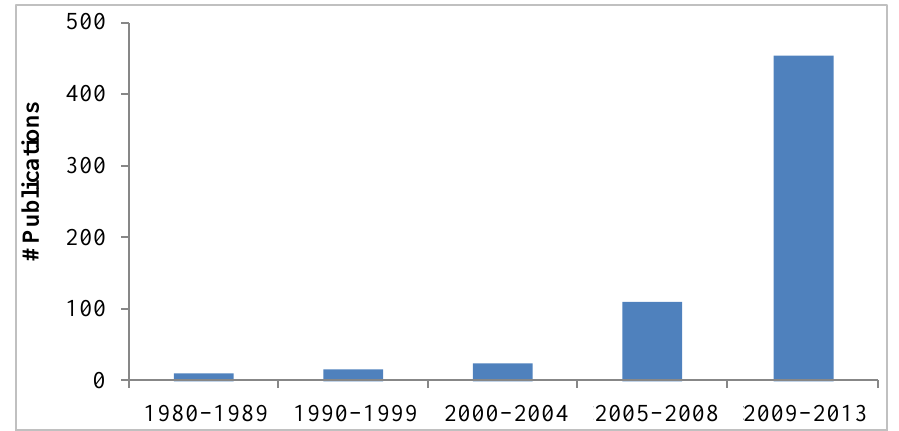
Figure 2. Number of publications related to mangosteen and their xanthones from 1980